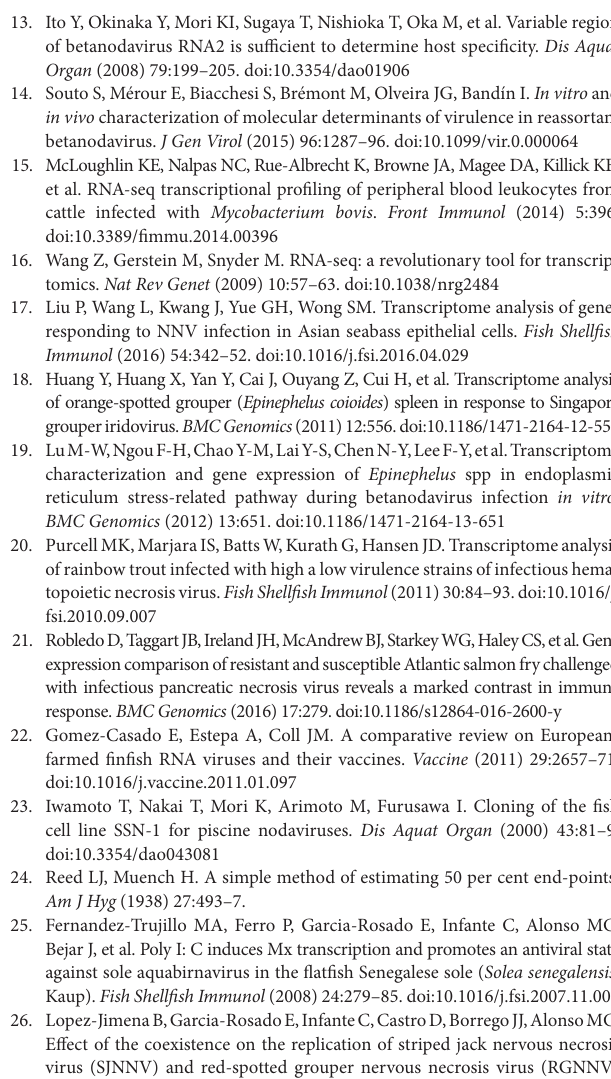
FigUre s1 | Agarose gel electrophoresis of total RNA extracted for RNA-Seq technology. (a) Head kidney samples. From left to right: control group (L15-R1, -R2, and -R3), wild-type reassortant (RG160/SJ160-R1, -R2, and -R3), and mutant reassortant (RG160/SJ160 m247 + 270-R1, -R2, and -R3). (b) Eye– brain samples. From left to right: control group (L15-OC1, -OC2, and -OC3), wild type reassortant (RG160/SJ160-OC1, -OC2, and -OC3), and